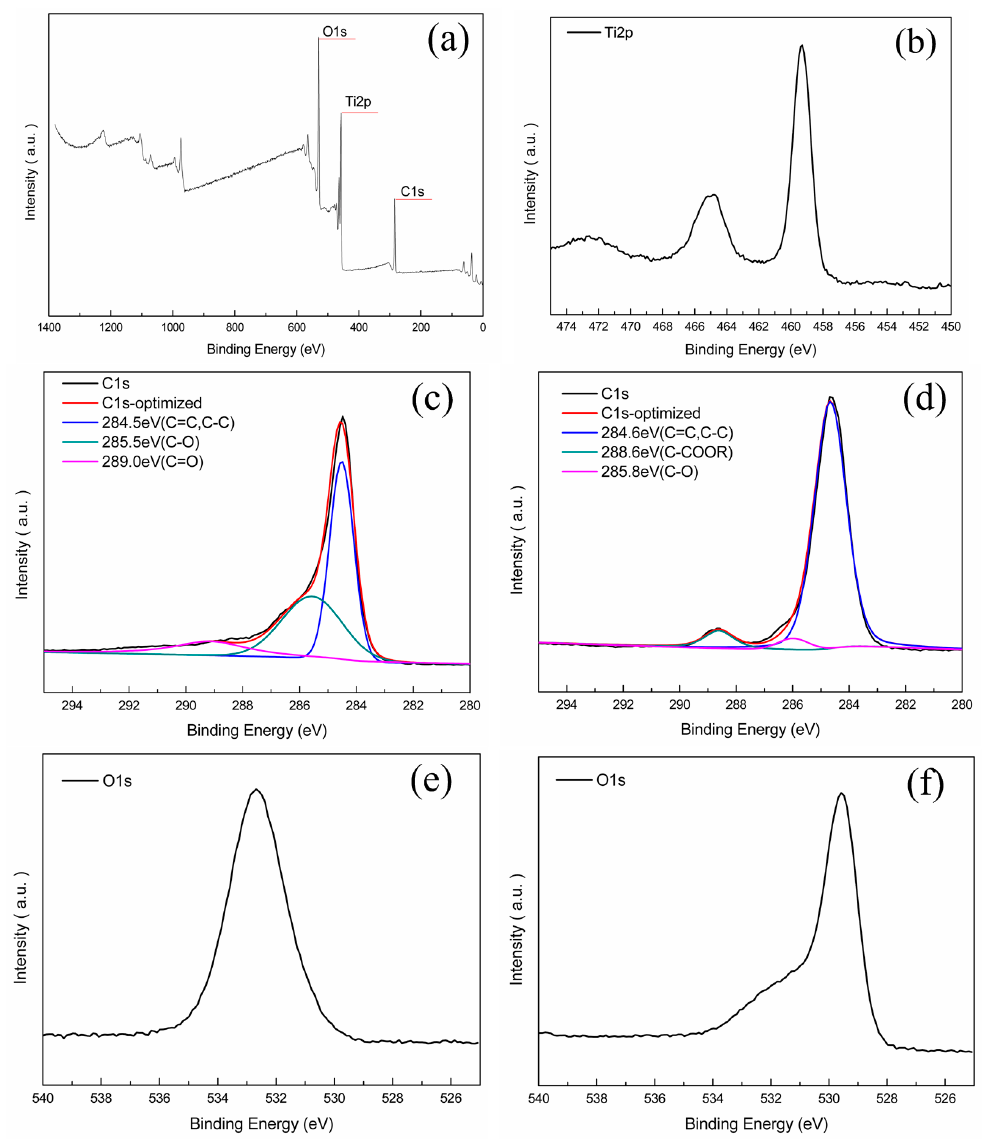
Figure 3. XPS spectra of the samples: ( a ) survey spectra of the nano-TiO 2 /carbon membrane; ( b ) Ti 2 p region of the nano-TiO 2 /carbon membrane; ( c ) C 1 s region of the original carbon membrane; ( d ) C 1 s region of the nano-TiO 2 /carbon membrane; ( e ) O 1 s region of the original carbon membrane; and ( f ) O 1 s region of the nano-TiO 2 /carbon membrane.